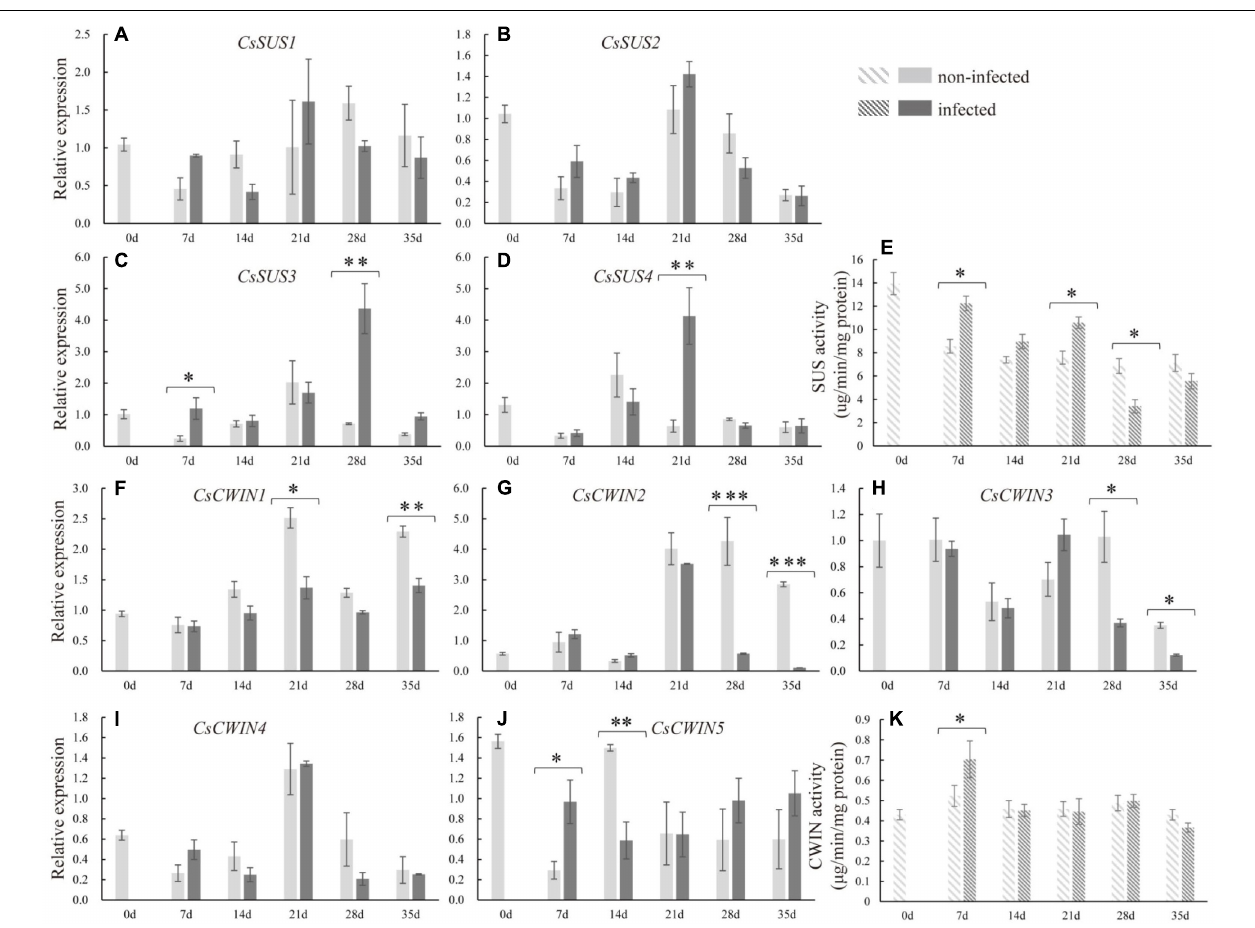
FIGURE 5 | Expression levels of sucrose synthase genes ( CsSUS1–4 ) (A–D) , cell wall invertase genes ( CsCWIN1–5 ) (F–J) , and the enzyme activity analysis of CsSUS (E) and CWIN (K) in infected and non-infected cucumber roots by M. incognita . Error bars represent ± SE ( n = 5). Student’s t -test is analyzed between infected and non-infected roots, ∗ P < 0.05; ∗∗ P < 0.01; ∗∗∗ P <